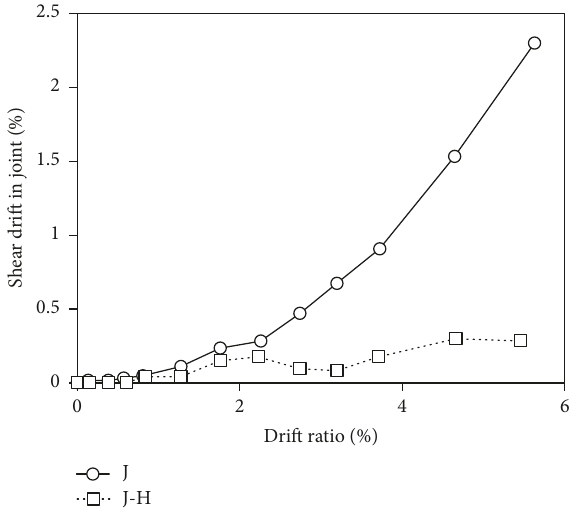
Figure 11: Joint shear deformation of test specimens.